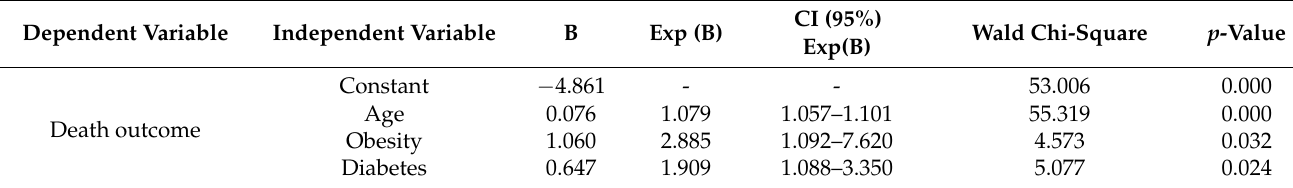
Table 4. Binomial logistic regression model used to estimate the probability of death of COVID-19 patients using primary data from 515